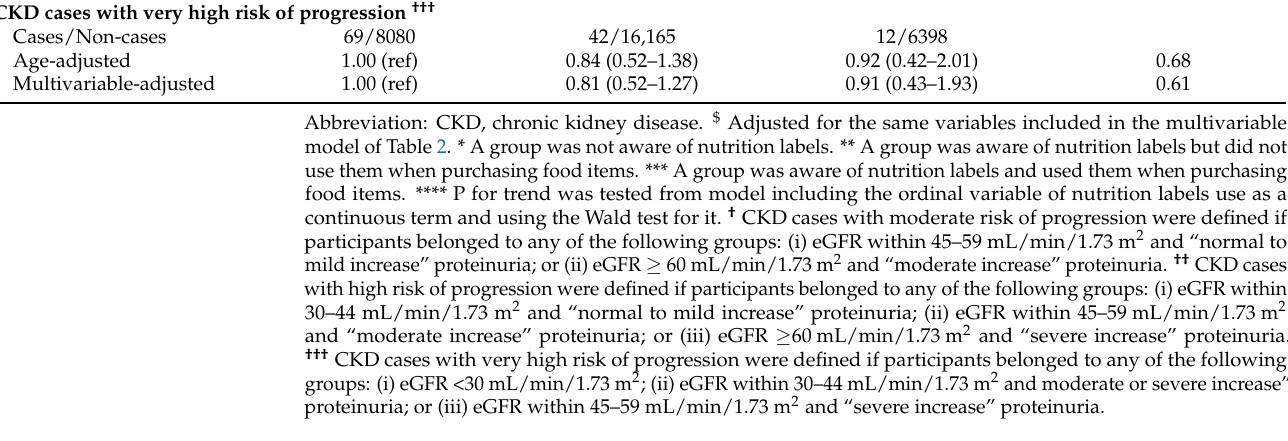
Table 4. Multivariable-adjusted $ odds ratio (95% confidence intervals) of overall CKD by use of nutrition labels according to population